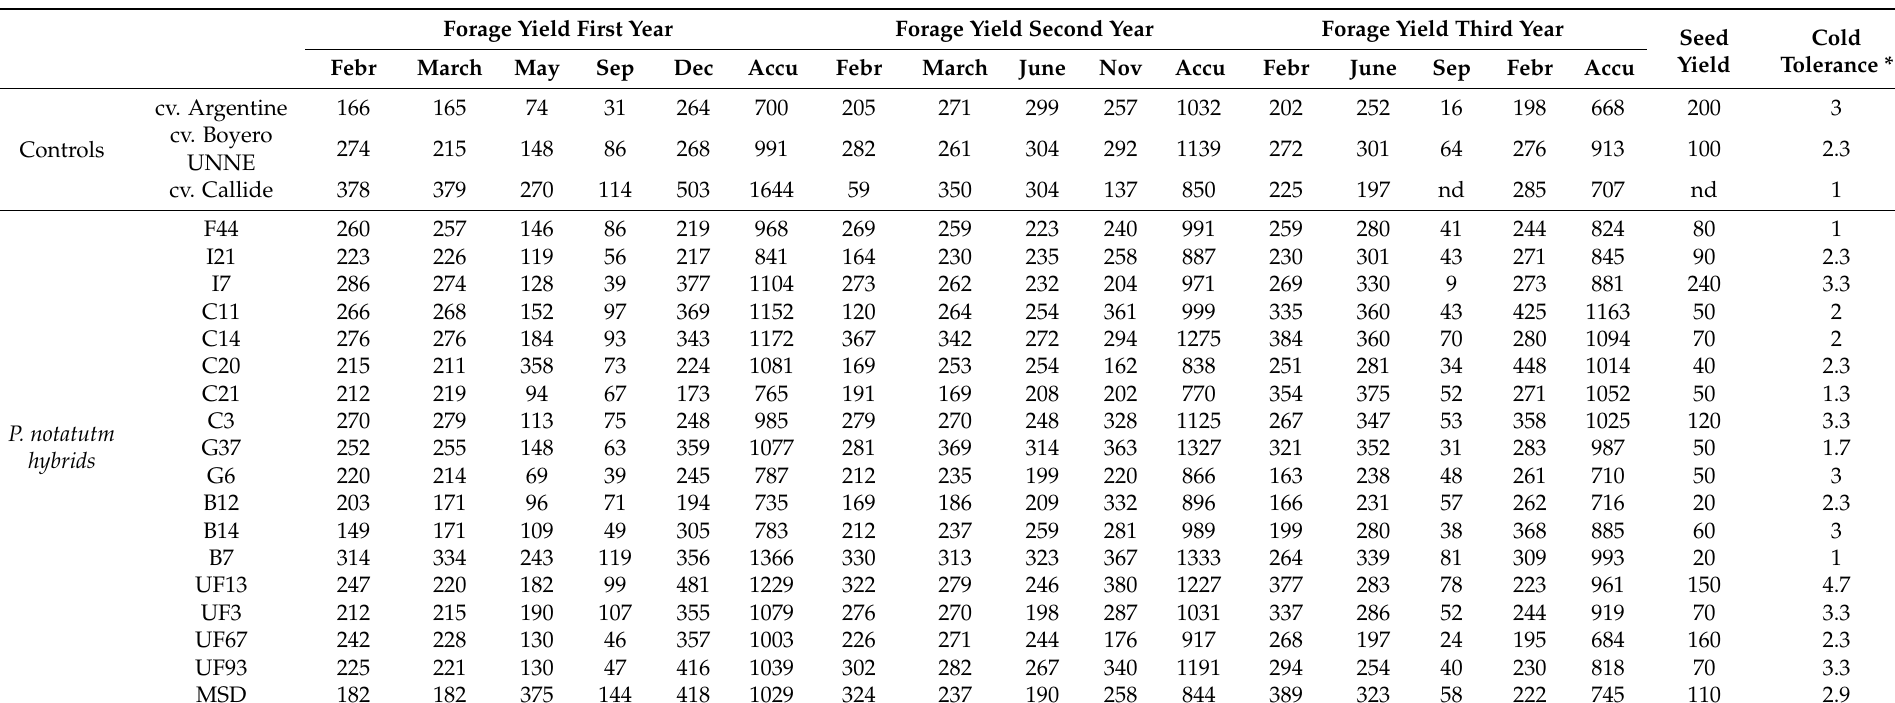
Table 2. Forage yield (g m − 2 ), seed yield (kg.ha − 1 ) and cold tolerance of a group of Paspalum notatum hybrids, cv Argentine, cv Boyero UNNE, and C. gayana cv Callide during three growing periods in Corrientes,